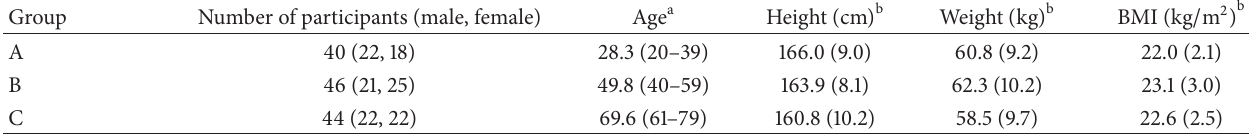
Table 1: Subject characteristics.